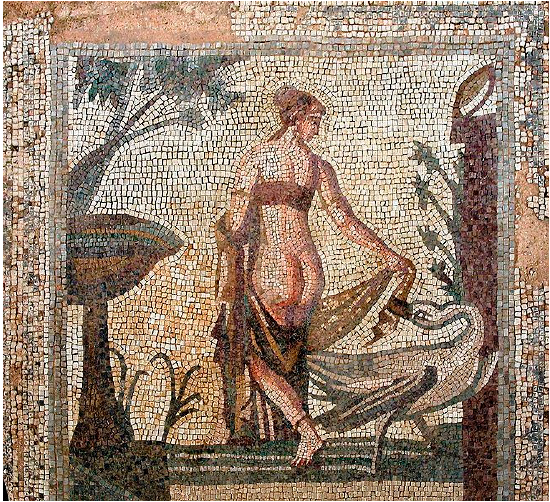
Figure 5. Imperial Roman mosaic of Leda and the Swan , C3rd A.D., © Cyprus Museum, Nicosi.